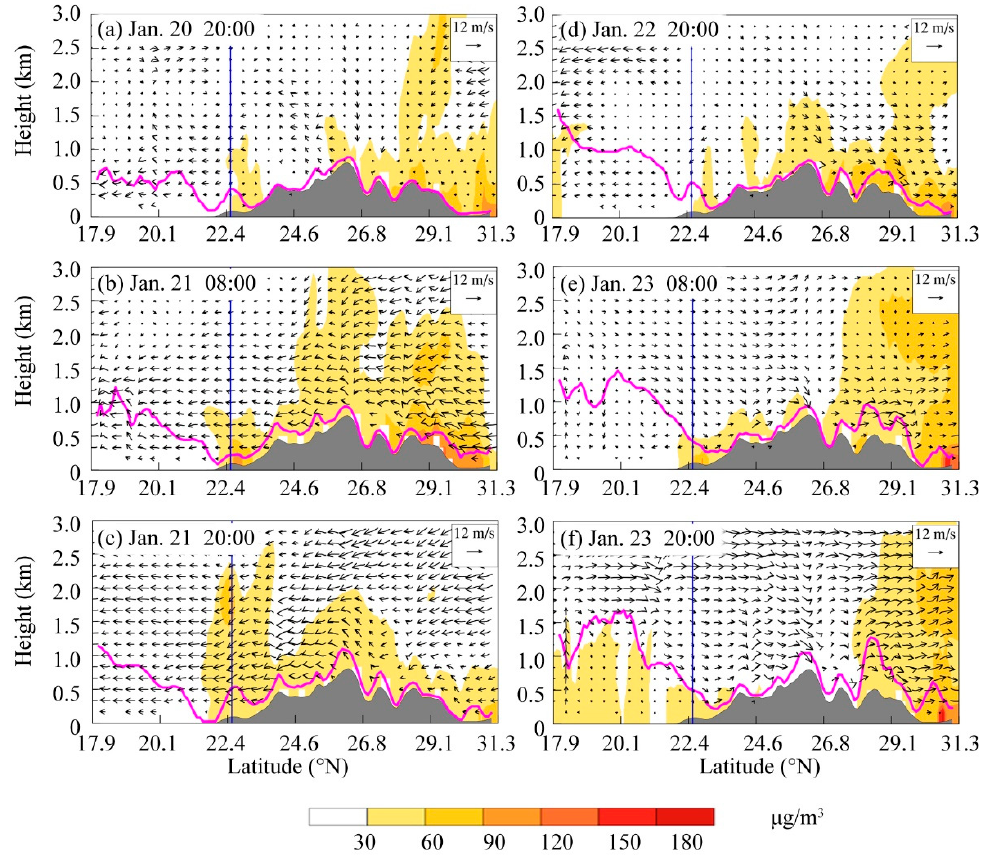
Figure 13. Vertical cross sections of the simulated PM 2.5 concentration (color shaded; units: µ g / m 3 ), wind field (black vector; unit vector: 12 m / s), PBLH (solid purple line; units: km) above the sea level, and terrain height (gray shaded; units: km). in the CTL experiment at ( a ) 20:00 on 20 January, ( b ) 08:00 on 21 January, ( c ) 20:00 on 21 January, ( d ) 20:00 on 22 January, ( e ) 08:00 on 23 January, and ( f ) 20:00 on 23 January. Blue perpendicular based on the latitude of SZ.